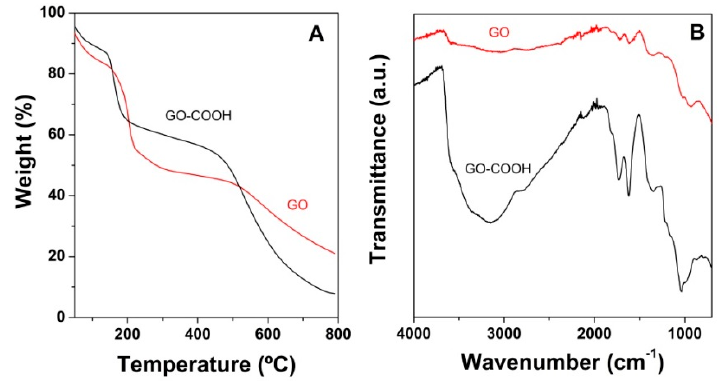
Figure 1. Thermogravimetric curves ( A ) and FTIR spectra ( B ) for graphene oxide (GO) and GO-COOH.